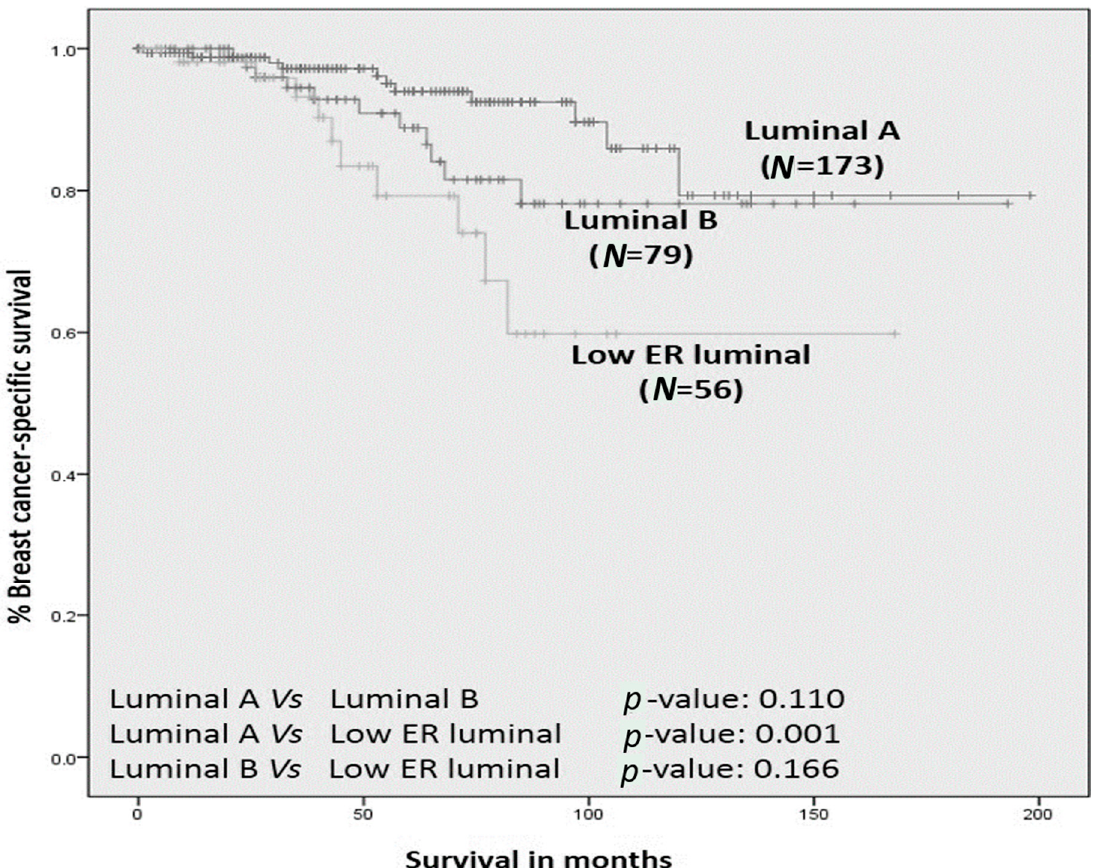
Figure 2. Older women with oestrogen receptor positive primary breast cancer: breast-cancer-specific survival of biological clusters.